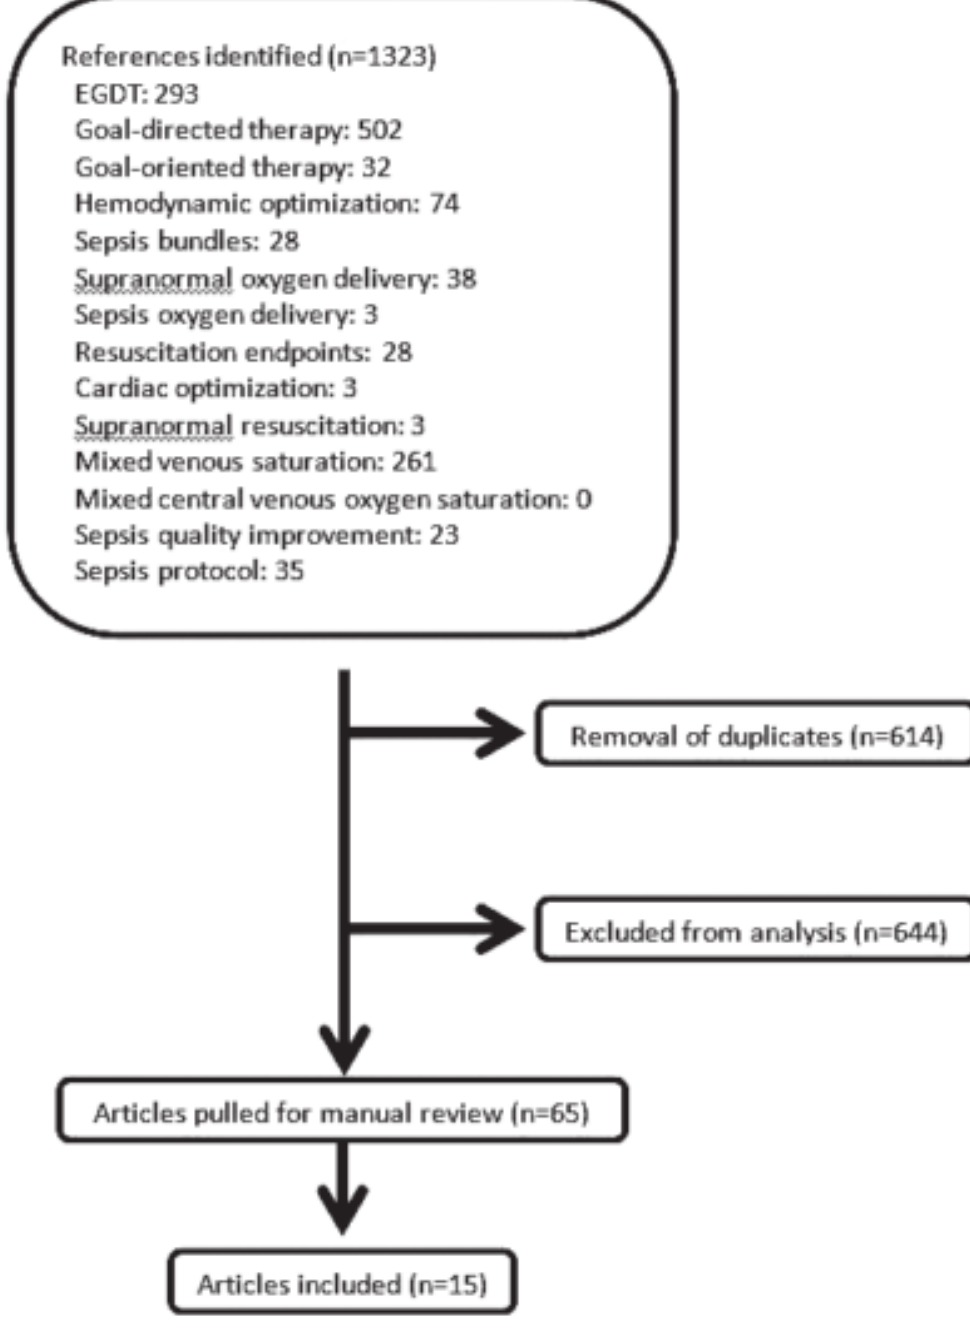
Figure 1. Flow chart of article extraction. EGDT , early goal-directed